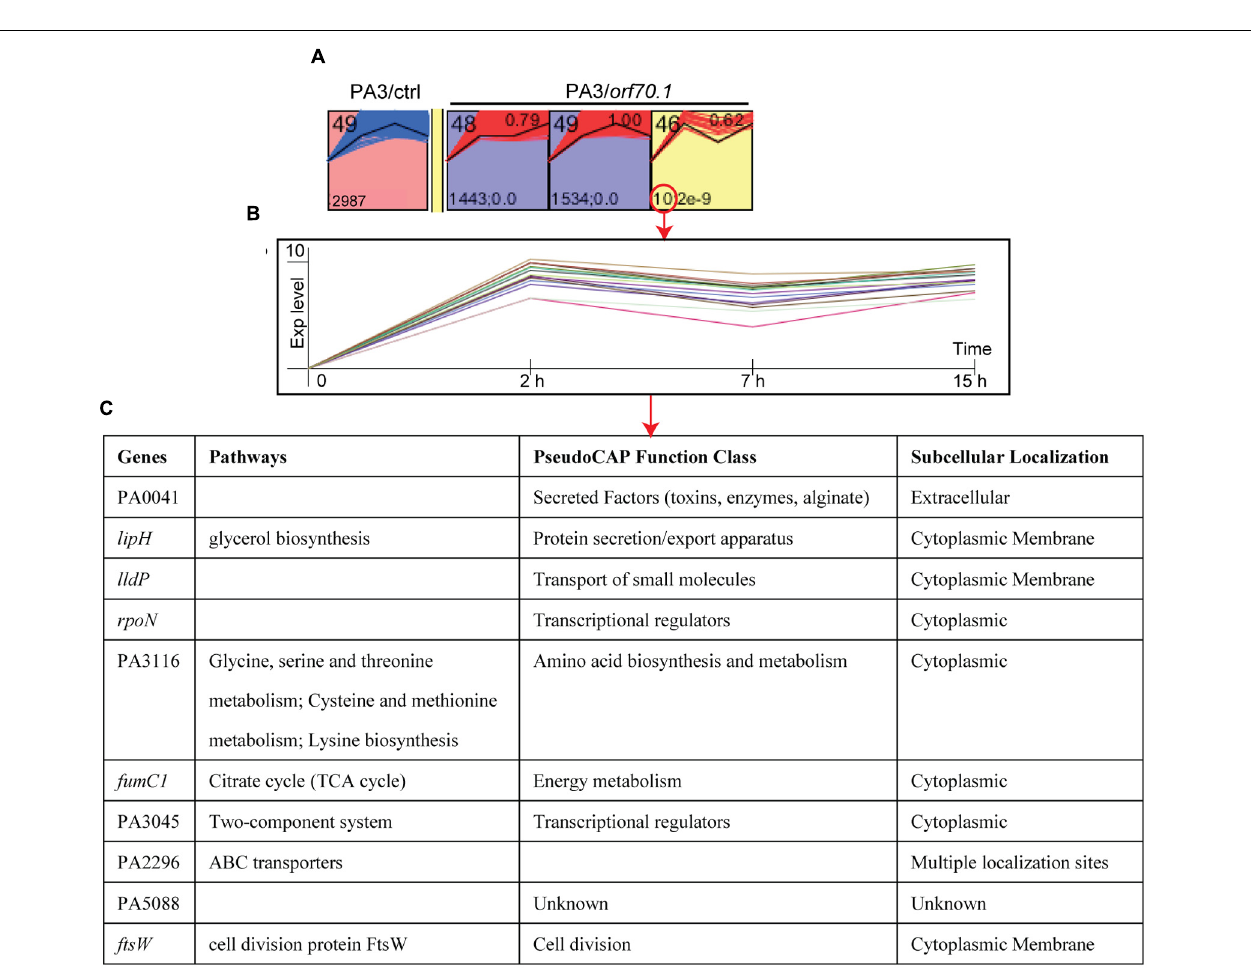
FIGURE 4 | STEM (Short Time-series Expression Miner) analysis of microarray data. A total of 49 model profiles are ordered by ID (top left). Each gene of PA3 was assigned to different model profiles based on the time series expression values (log ratios) from different experimental conditions (PA3/ctrl or PA3/ orf70.1 ). (A) Profiles with significant difference between the original set profile (PA3/ctrl) and comparison set profile (PA3/ orf70.1 ). The first expression values were transformed into 0. The expression pattern containing 2,987 PA3 genes was changed from profile 49 into profile 48 (1,443 genes, p = 0), 49 (1,534 genes, p = 0) and 46 (10 genes, p = 2 e − 9) when overexpressed gp70.1 in PA3. Profile 46 shows the minimum correlation ( r = 0.62, upper right). (B) Detailed model profile information of the most changed 10 genes in profile 46. (C) The information of pathway, function, and subcellular localization of the 10